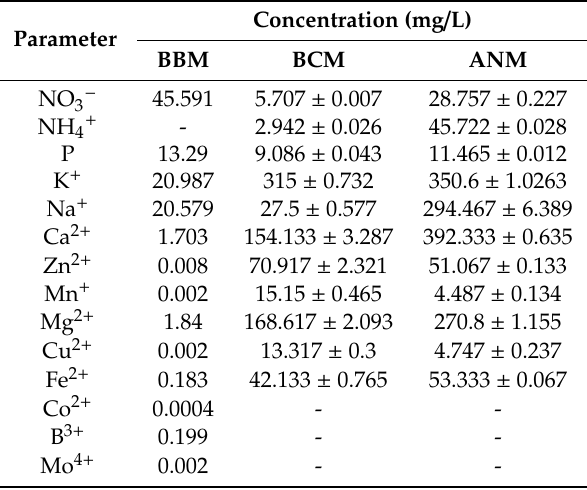
Table 1. Nutrient composition of C. vulgaris grown in di ff erent media